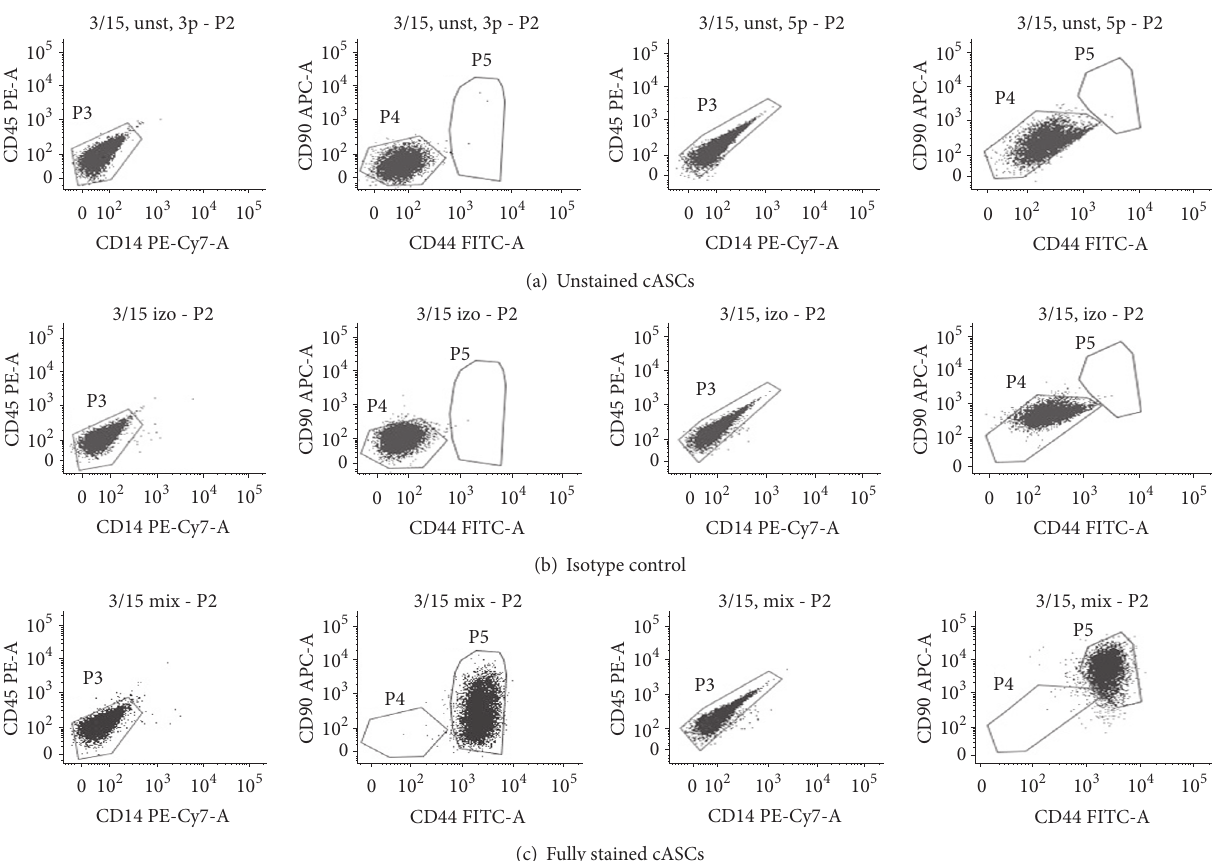
Figure 3: Flow cytometry results. The most representative canine adipose derived stem cells from one donor are shown in passage 3 and 5. The figure shows P2 population after excluding dead cells and doublets. CD: cluster of differentiation, APC: allophycocyanin, PE: Phycoerythrin, FITC: fluorescein isothiocyanate, and PE-Cy7: R-Phycoerythrin-Cyanine